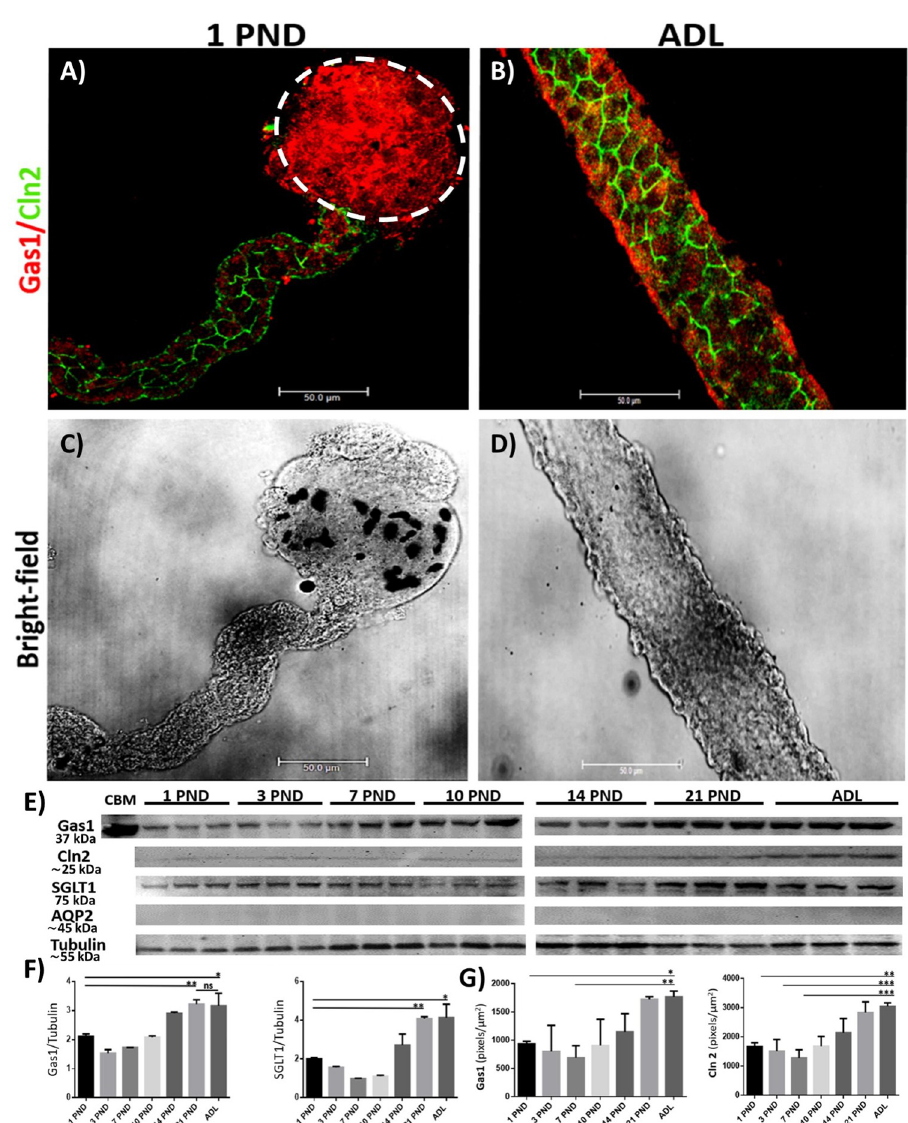
Fig 5. Comparison of Gas1 expression and claudin 2 (Cln2) in the proximal convoluted tubule in the newborn and adult rat. A and B) immunofluorescence of proximal convoluted tubules isolated from the renal cortex of rats from PND 1 and ADL. We found a pattern of increasing expression of Gas1 and Cln2 as the kidney matures. C) bright-field of an isolated proximal tubule attached to its respective glomerulus from PND 1. D) bright-field of an isolated proximal tubule from an adult rat, found to be thicker compared to that of 1 PND. The immunofluorescence methodology used for the tubules and the glomerulus are different, for this reason the signal observed from Gas1 in the glomerulus (A, delimited by a white circular line) does not correspond to the expression described previously (Fig 2), the image is shown as a positive control of the proximal tubule, since anatomically only the proximal tubule is attached to the glomerulus. E) Western blot analysis of Gas1 in an enriched sample of proximal tubules, we used as a negative control the protein (distal nephron protein) aquaporin 2 (AQP2). As a positive control for Gas1 we used a sample of the cerebellum (CBM). We did not find a significant signal from AQP2, confirming that the analyzed samples were mainly from the proximal region. F) densitometric analysis of the Western blot of Gas1 and SGLT1. Each PND analyzed is expressed as the relative density of a group of 20 (younger ages) and 8 (21 PND and adult) rats normalized with α -tubulin as loading control. G) semi-quantitative analysis of Gas1 and Cln2 in the proximal tubule. Gas1 (red) and Cln2 (green) are shown. Scale bars = 50 μ m. Values are means ± standard deviation (SD). One-way ANOVA. * p < 0.05, **** p < 0.0001. Immunofluorescence experiments were performed in isolated renal tubules. A representative experiment is shown (n =